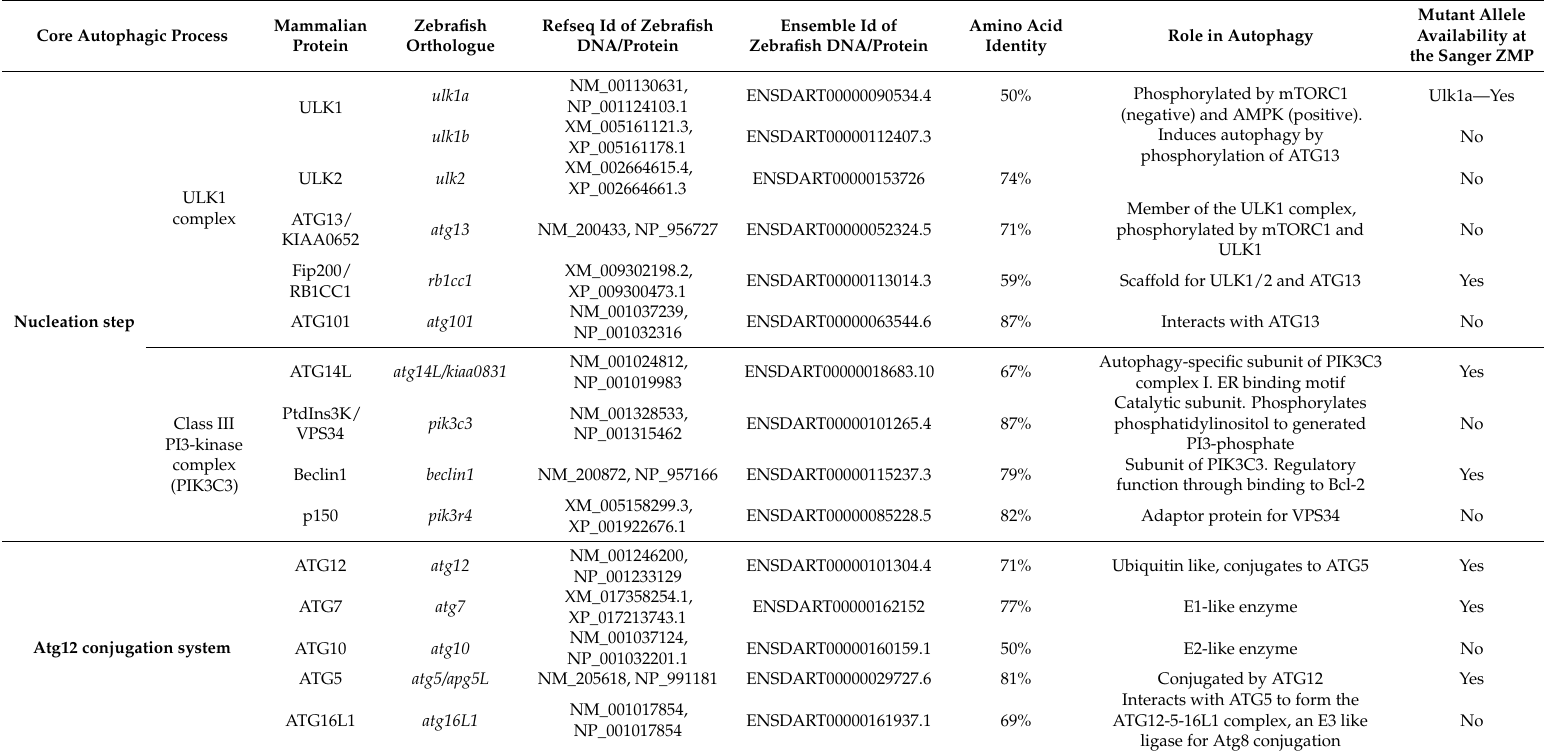
Table 1. Zebrafish ( Danio rerio ) orthologues of human autophagy genes, with amino acid percentage identity and allele availability at the Sanger ZMP. ULK: UNC-51-like kinase; ZMP: Zebrafish Mutation Project; PE: phosphatidylethanolamine, mTORC1: Mammalian Target of Rapamycin Complex 1, AMPK: Adenosine Mono-Phosphate Kinase; ER: Endoplasmic Reticulum; PtdIns3K: Phosphatidylinositol 3-Kinase; VPS34: Vacuolar Protein Sorting